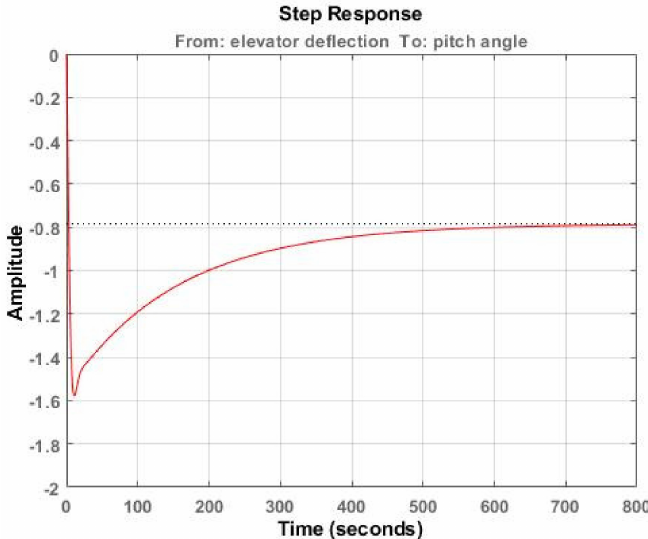
Figure 1. Open − loop step response of Boeing 747 pitch angle dynamic.